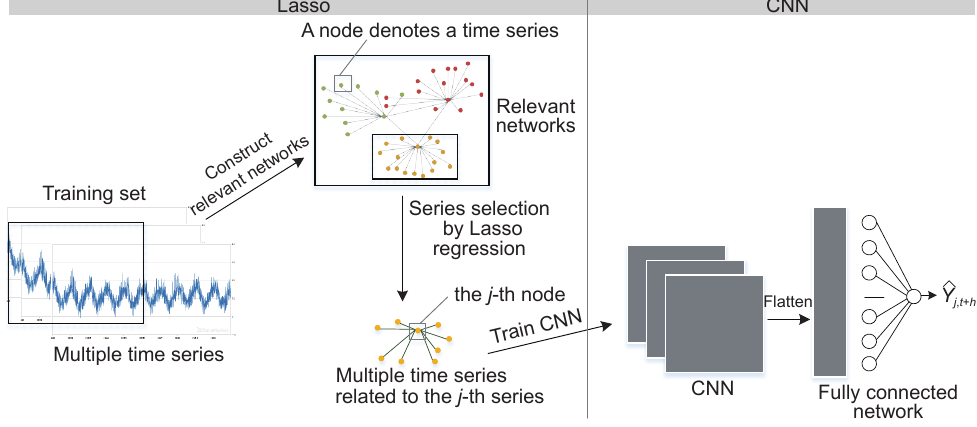
Fig. 1 Framework of the Lasso-CNN